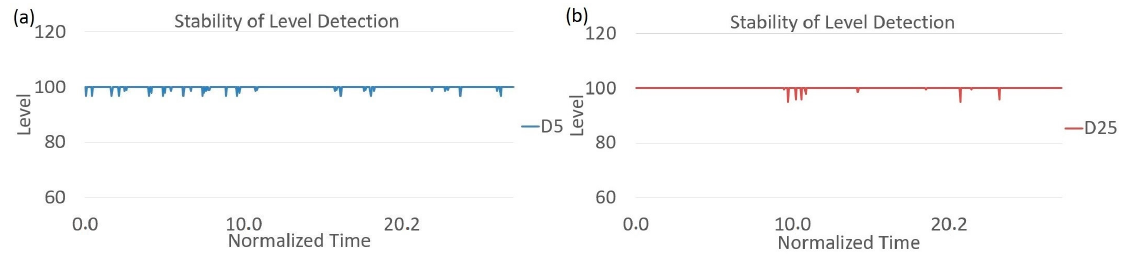
Figure 13. Stability of level detection for ( a ) Dextrose 5% in Water (D5); ( b ) Dextrose 25% in Water (D25).